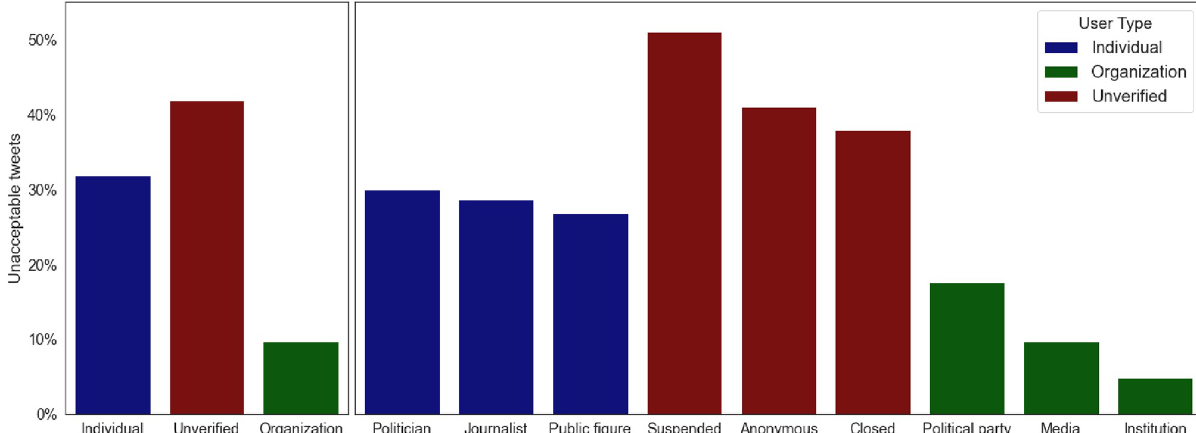
Fig 7. Fractions of unacceptable tweets posted by different types of users. The left bar chart shows major user types. Each major user type consists of three subtypes, shown at the right bar chart with the same color. Individual bars indicate the fraction of all tweets posted by the user (sub)type that are unacceptable.